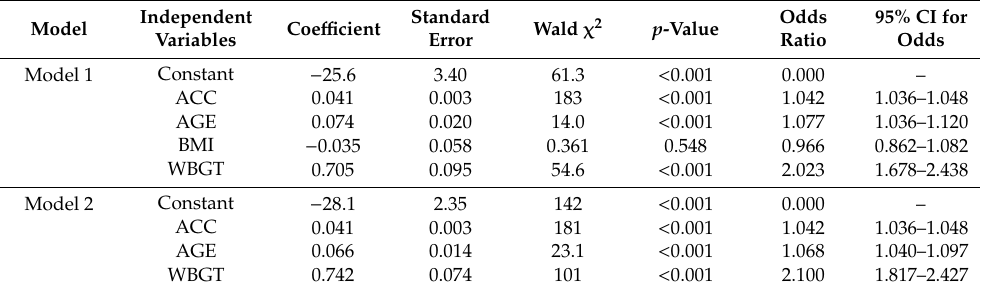
Table 9. Estimation by logistic regression model.